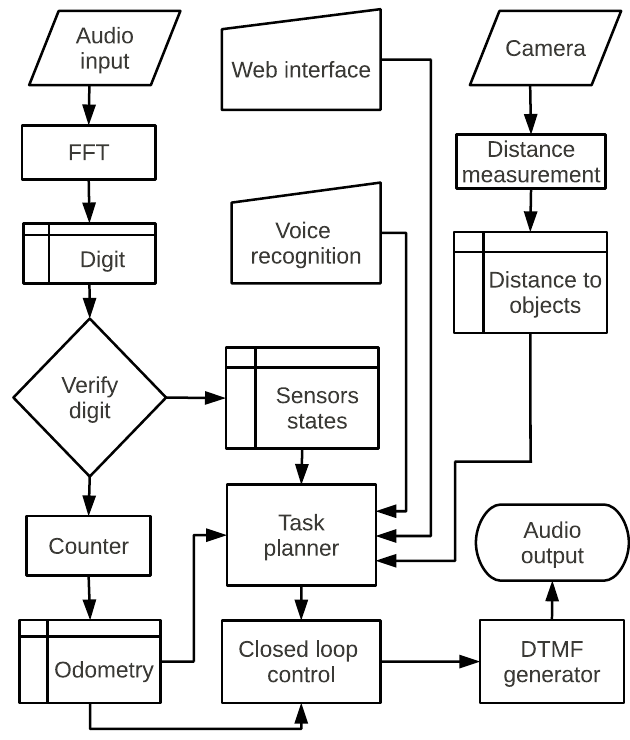
Figure 8. Block diagram of the robot’s